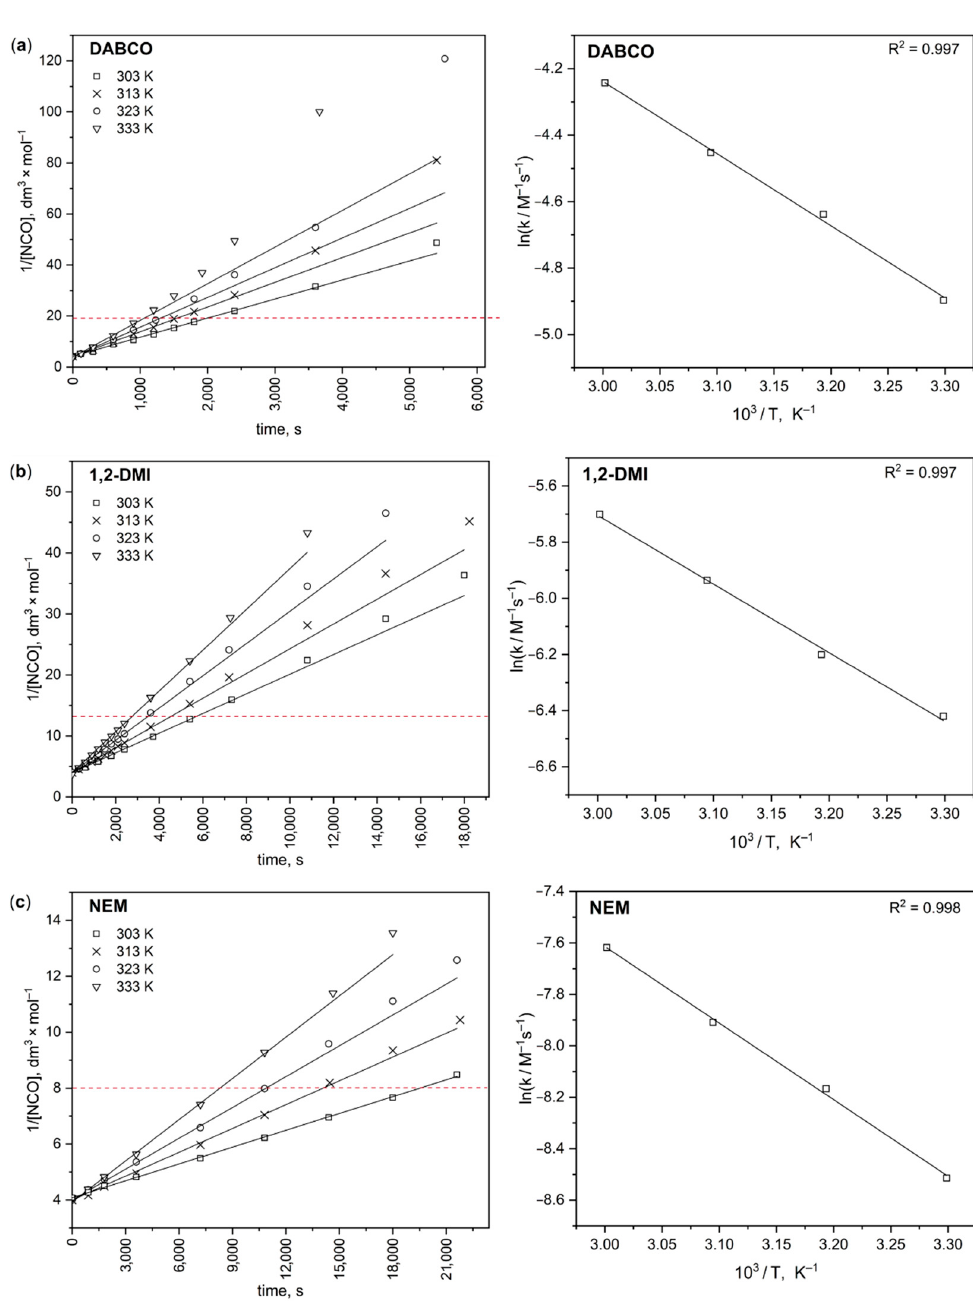
Figure 3. ( a ) Experimental kinetic curve (left) and Arrhenius plot (right) for urethane formation in the presence of 1,4-diazabicyclo[2.2.2]octane (DABCO) catalyst. ( b ) Experimental kinetic curve (left) and Arrhenius plot (right) for urethane formation in the presence of 1,2-dimethylimidazole (1,2-DMI) catalyst. ( c ) Experimental kinetic curve (left) and Arrhenius plot (right) for urethane formation in the presence of N -ethylmorpholine (NEM) catalyst. Data points up to approximately 50–80% PhNCO conversion (indicated by the red, dotted lines) were used for fitting and rate constant determination.